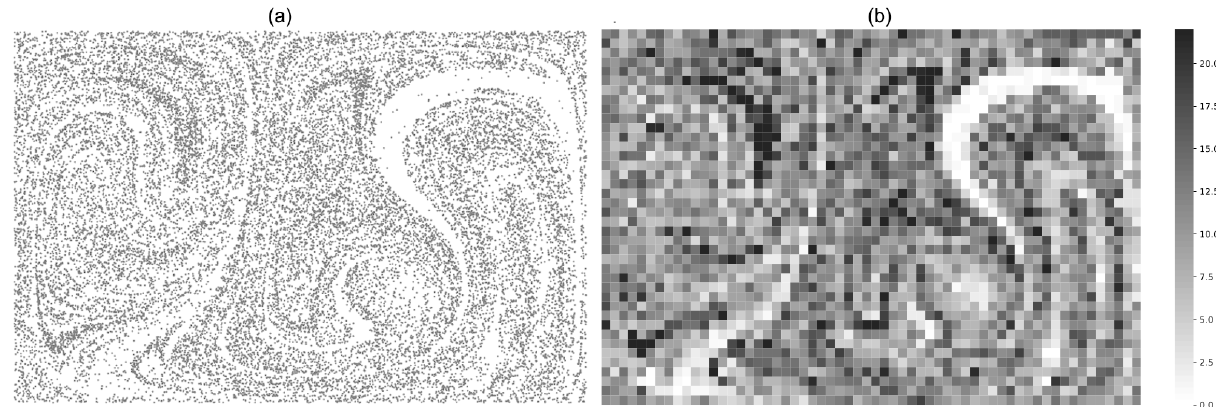
Figure 2. Generated particles (a) in a double-gyre flow field with OpenDrift and the corresponding plastic concentration field in particles per grid area (b) . The domain grid size is 60 × 40.